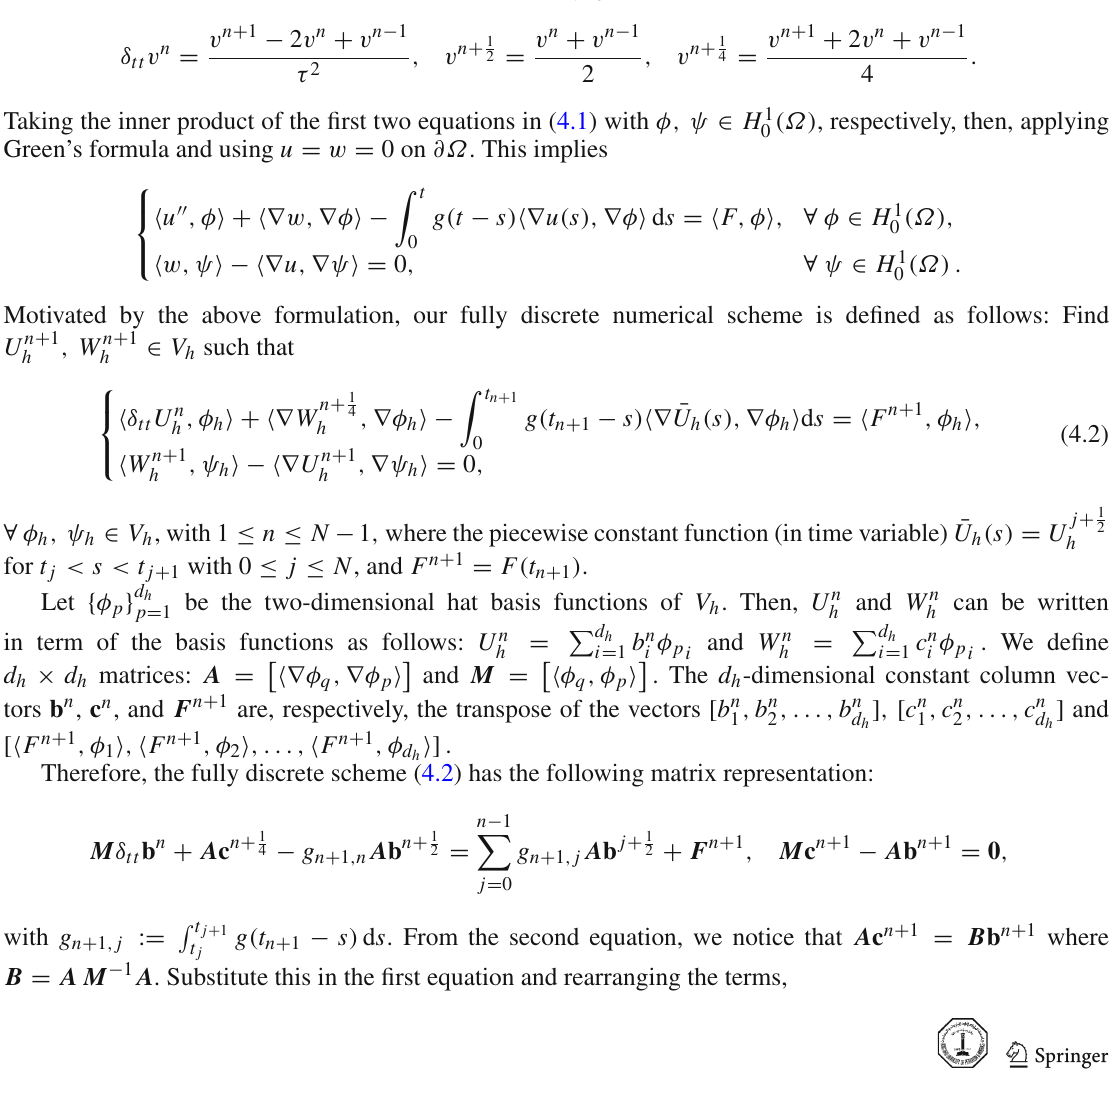
. For a given grid function v n , n = 0